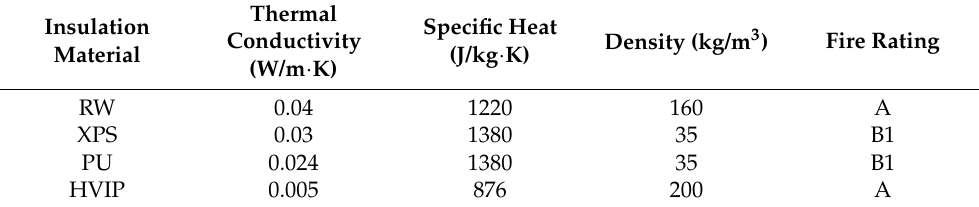
Table 3. Characteristics of the selected insulation materials.